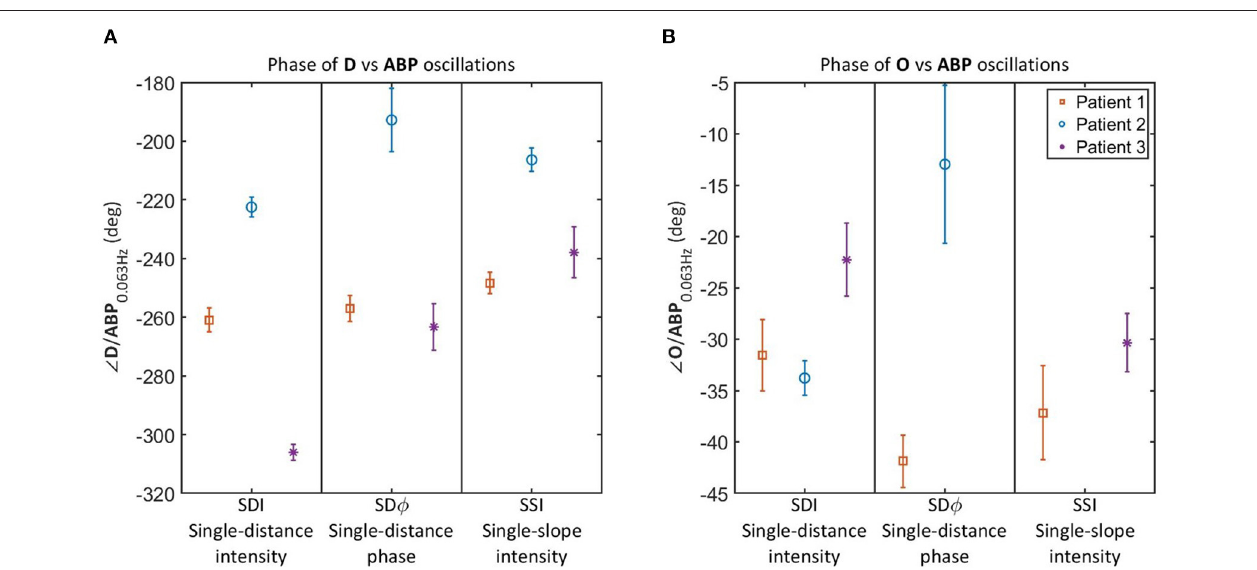
FIGURE 4 | Relative phase of D vs. ABP (A) and O vs. ABP (B) for oscillations at 0.063 Hz in 3 NCCU patients measured with single-distance intensity (SDI), single-distance phase (SD φ ), and single-slope intensity (SSI). Color and marker style are consistent for each subject. Error bars represent the standard errors of the measurements. Data for SD φ in patient 3 and SSI in patient 2 are missing due to a coherence level below the threshold.